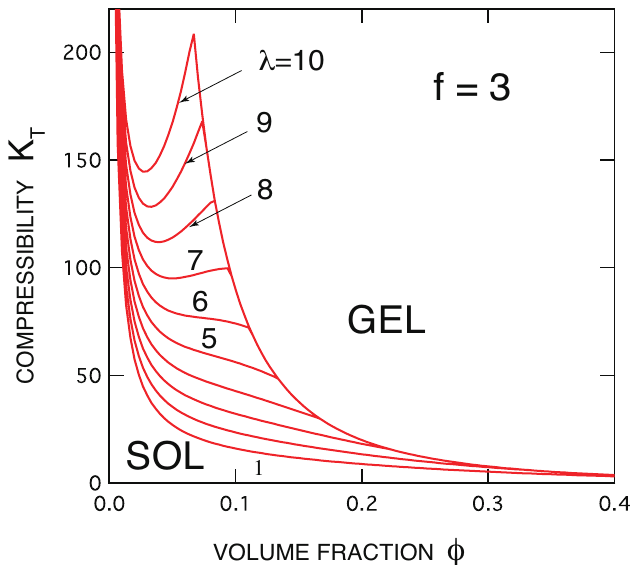
Figure 2. The osmotic compressibility K T ≡ ( ∂φ / ∂ ( π a 3 / k B T )) / φ plotted against the volume fraction of the primary molecules of low molecular weight ( n = 1). The functionality of the molecule is fixed at f = 3. The association constant is varied from curve to curve. It is continuous across the gel point, but its concentration derivative is